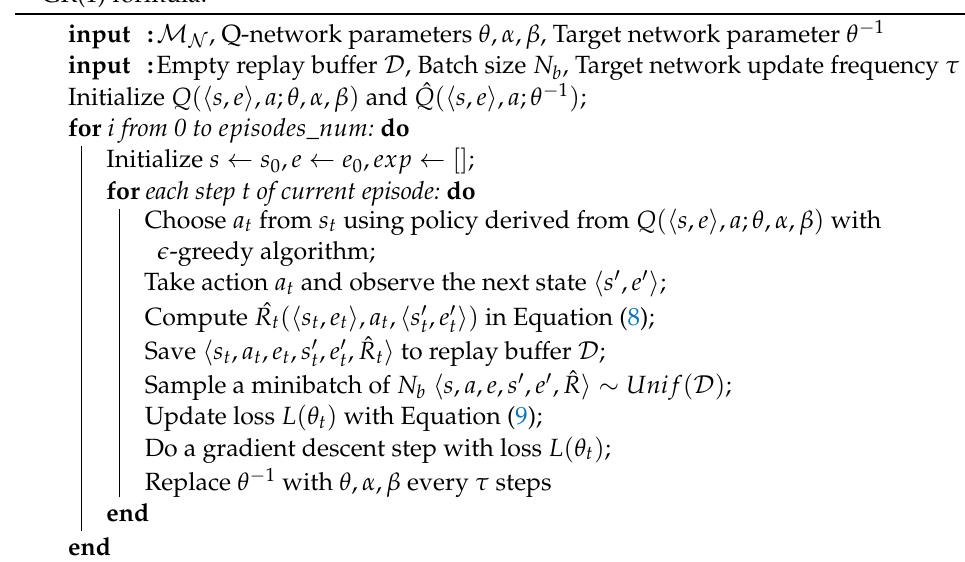
Algorithm 1: Dueling Double Deep Q-Network on GR(1)